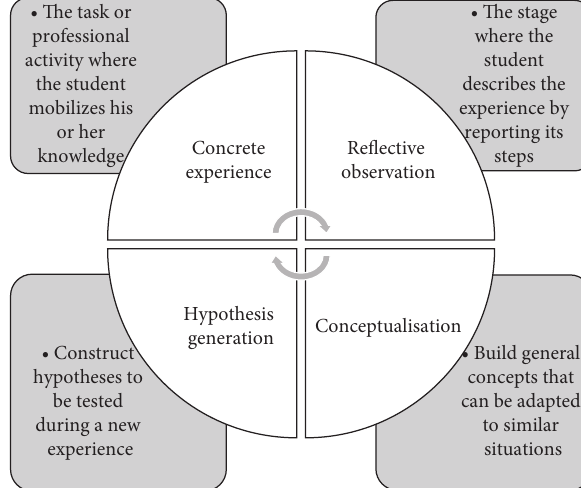
Figure 3: Kolb’s learning cycle.